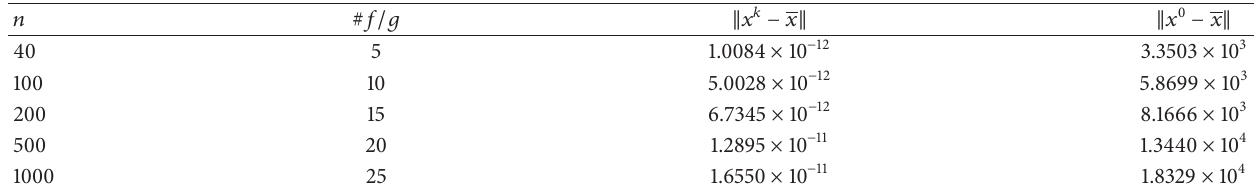
Table 1: Numerical